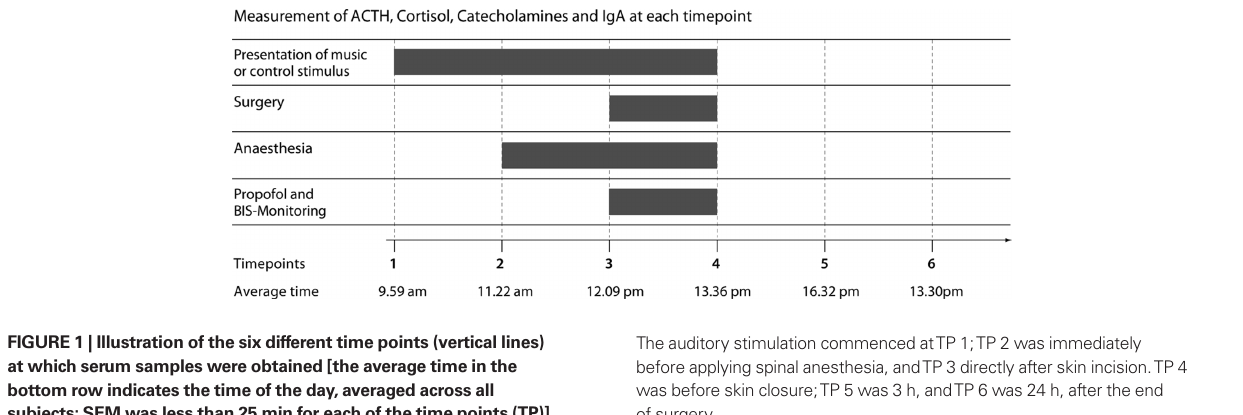
FIgure 1 | Illustration of the six different time points (vertical lines) at which serum samples were obtained [the average time in the bottom row indicates the time of the day, averaged across all subjects; SeM was less than 25 min for each of the time points (TP)].